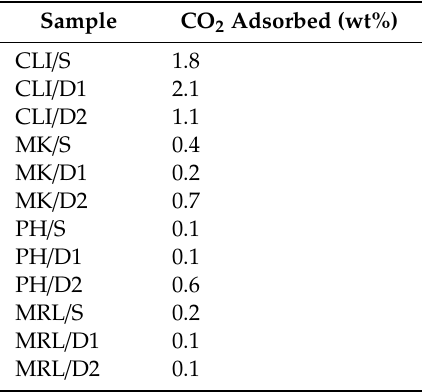
Table 3. Sorption properties determined by thermogravimetric analysis (TGA).